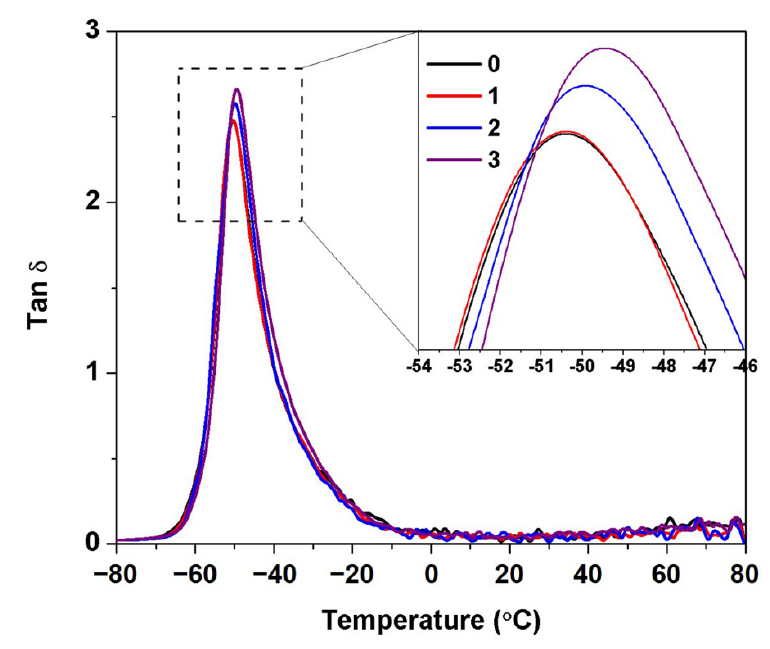
Figure 9. Tan δ as a function temperature for DPNRs with different counts of centrifugation cycles.